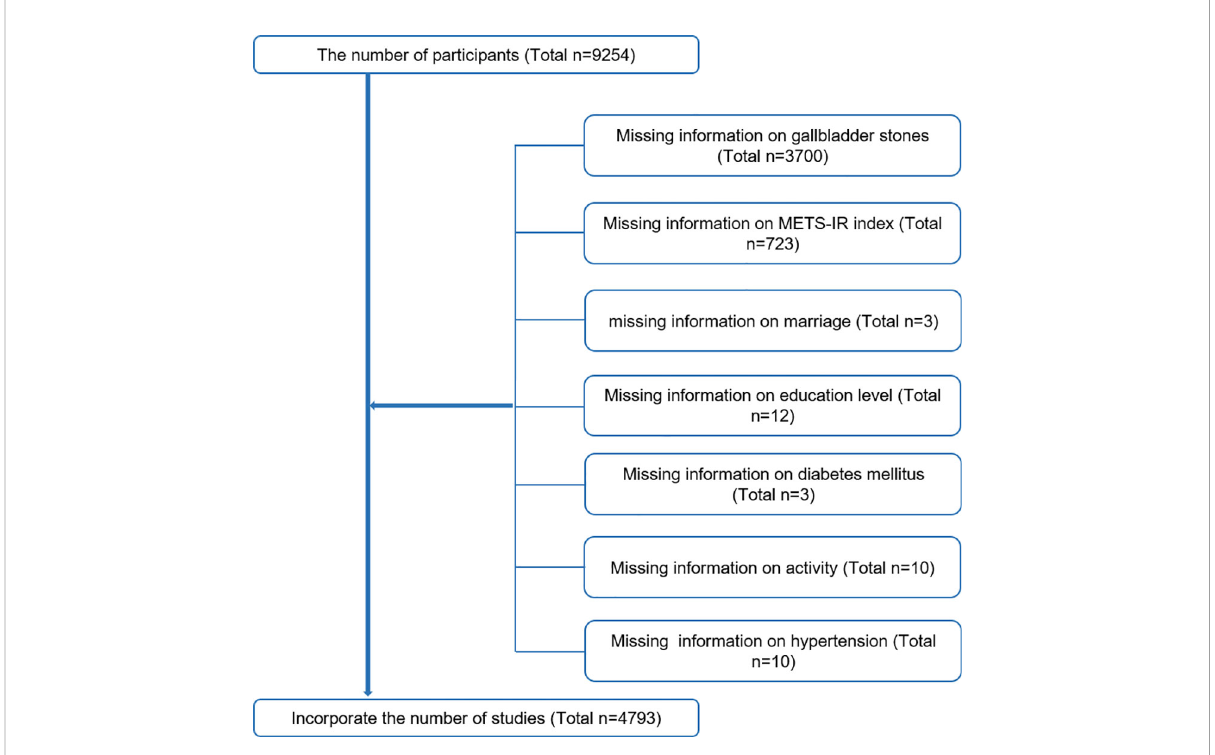
FIGURE 1 Sample selection fl owchart from NHANES 2017 –